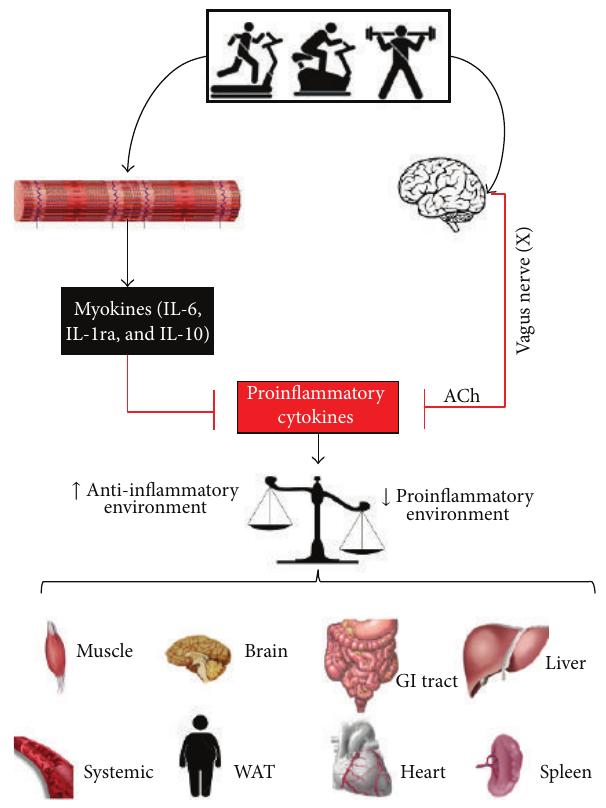
Figure3:Possibleanti-inflammatorypathwaysmodulatedbyphysicalexercise. Ach=acetylcholine; 𝛼 7nAChR=receptor 𝛼 7 subunit;WAT = white adipose